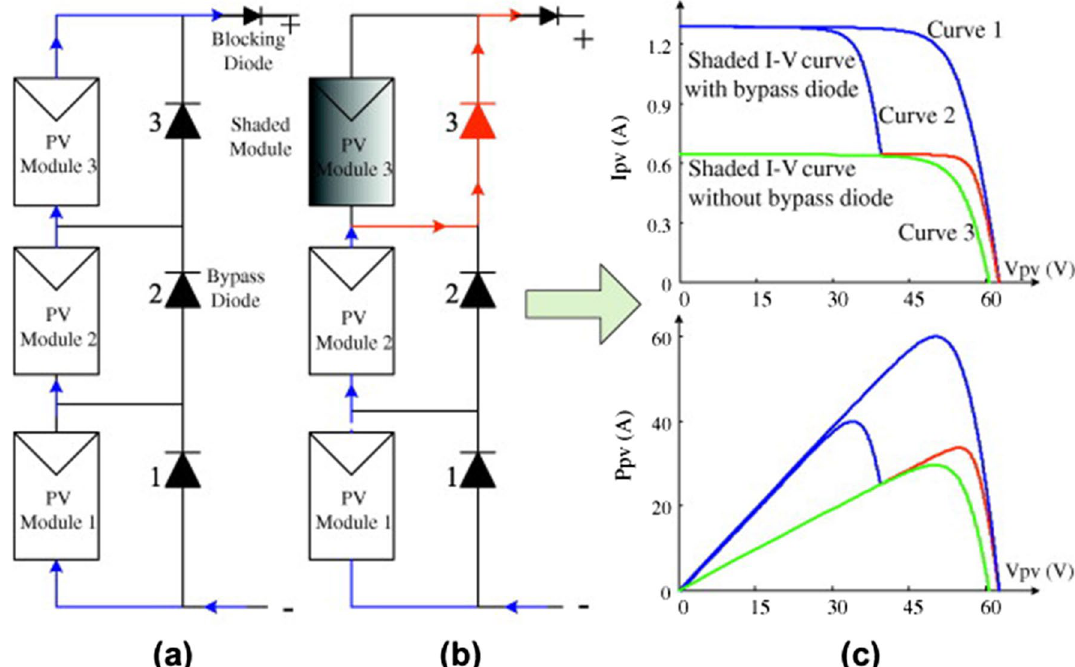
Fig. 2 Operation of PV array a under uniform irradiance, b under partial shading, c the resulting I–V and P–V curve for ( a ) and ( b )